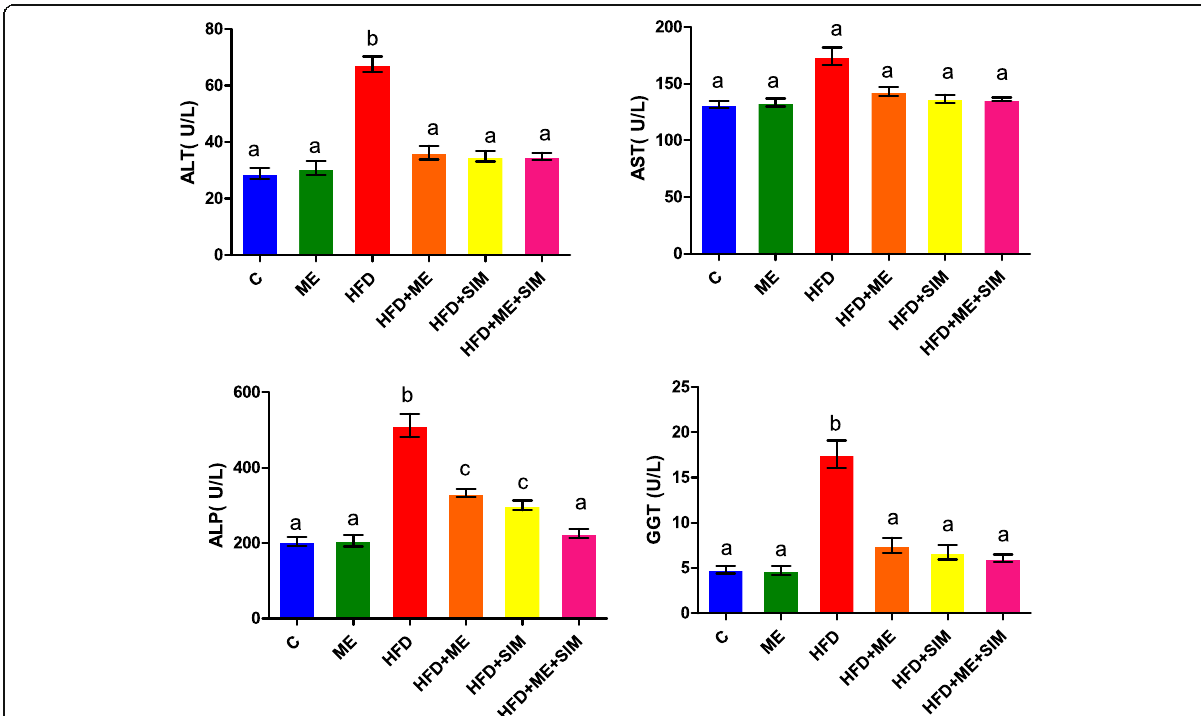
Fig. 4 The effects of Moringa leaf extract (ME), simvastatin (SIM) and their combination (ME+SIM) on the activities of serum aspartate amino transferase (AST), alanine amino transferase (ALT), alkaline phosphatase (ALP) and gamma glutamyltransferase (GGT) in rats fed a high-fat diet (HFD) for 6 weeks. ME protected liver tissue, which was indicated by the maintenance of comparable activities to the control. Different letters indicate significant differences between groups (p < 0.05). Values are means ±SD (n =